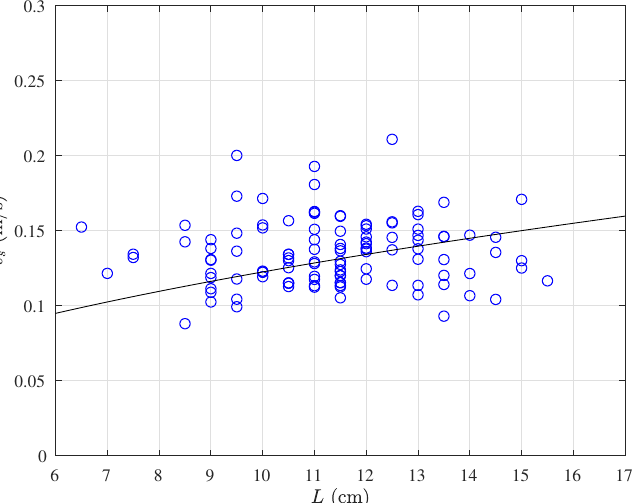
Figure 14. Measured settling velocity of Asterias rubens as a function of length. The solid line corresponds to